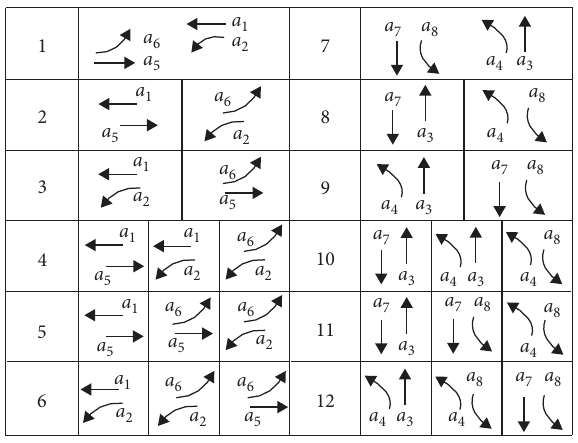
Figure 4: Phase schemes corresponding to the controlled trafc fow at